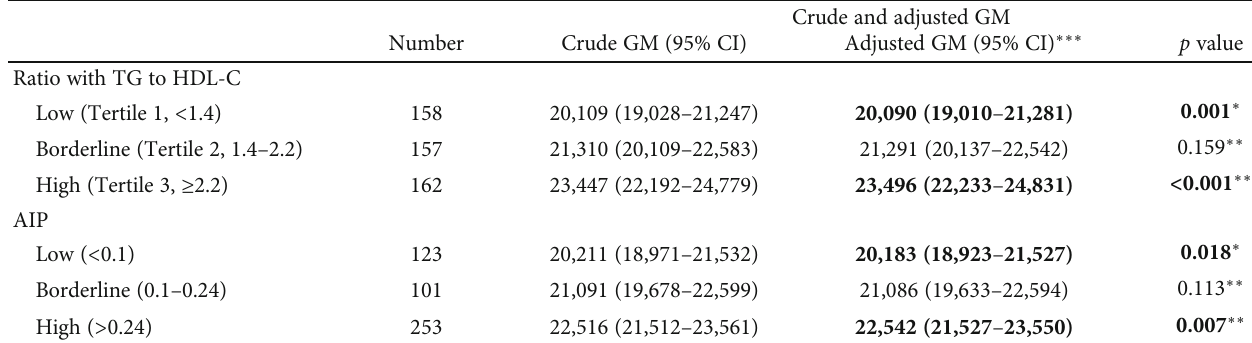
Table 3: Correlation between serum YKL-40 levels and